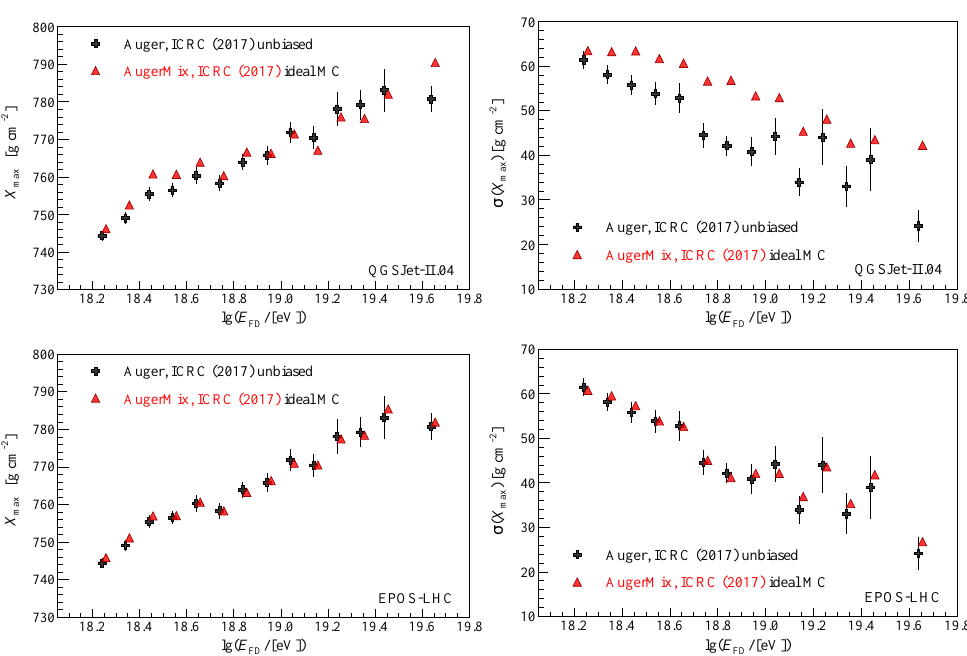
(cid:105) and σ ( X ) in the Auger data and in the AugerMix compositions obtained with QGSJetII-04 (top) max max